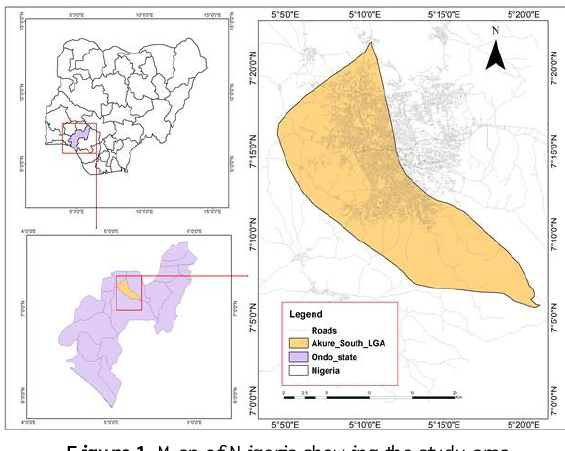
Figure 1. Map of Nigeria showing the study area